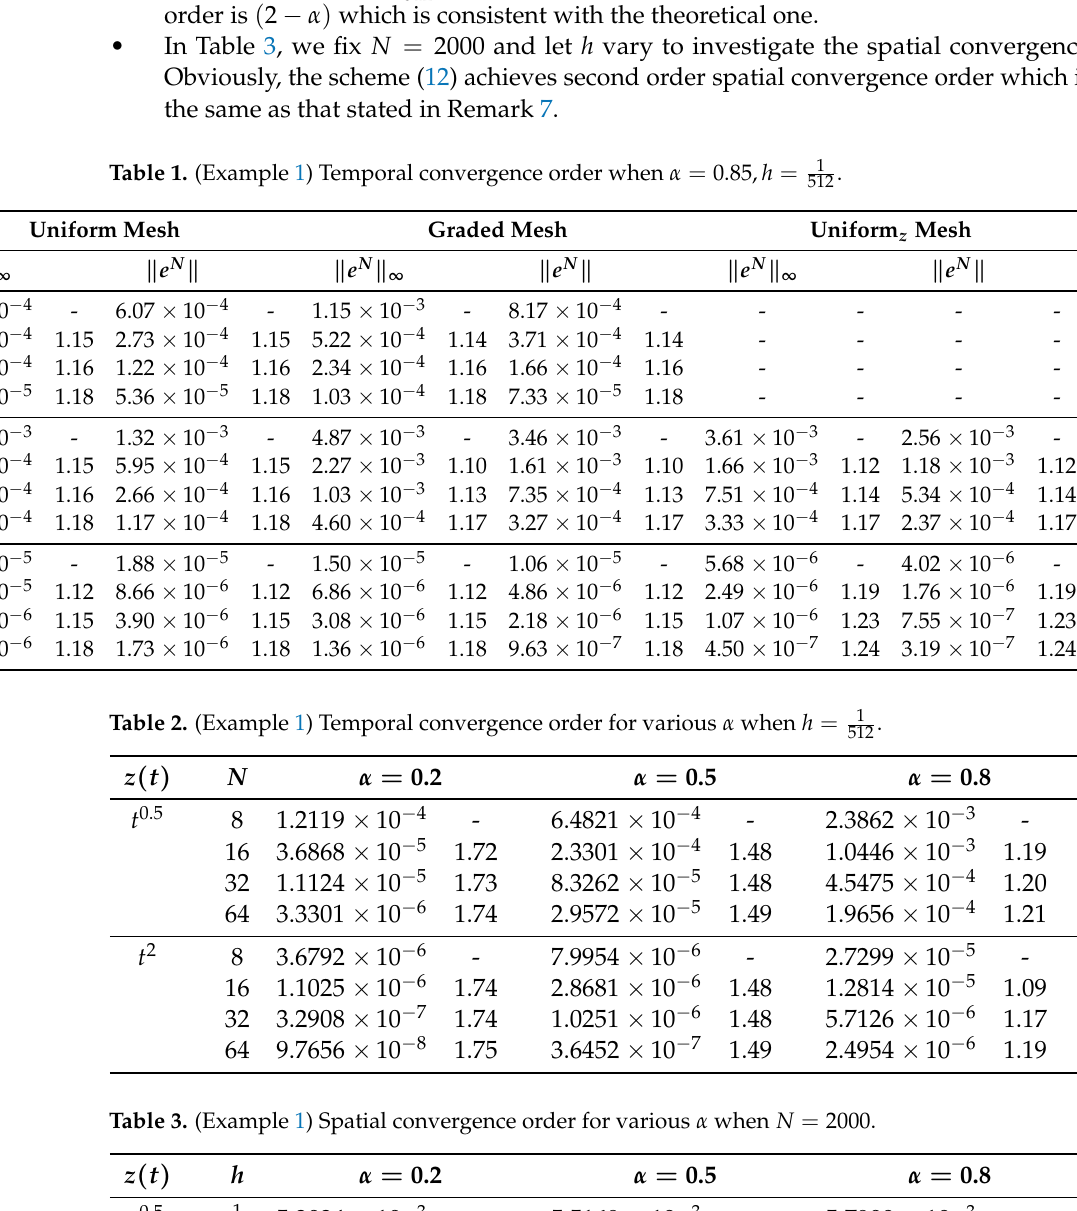
Table 1. (Example 1) Temporal convergence order when α = 0.85, h = 1